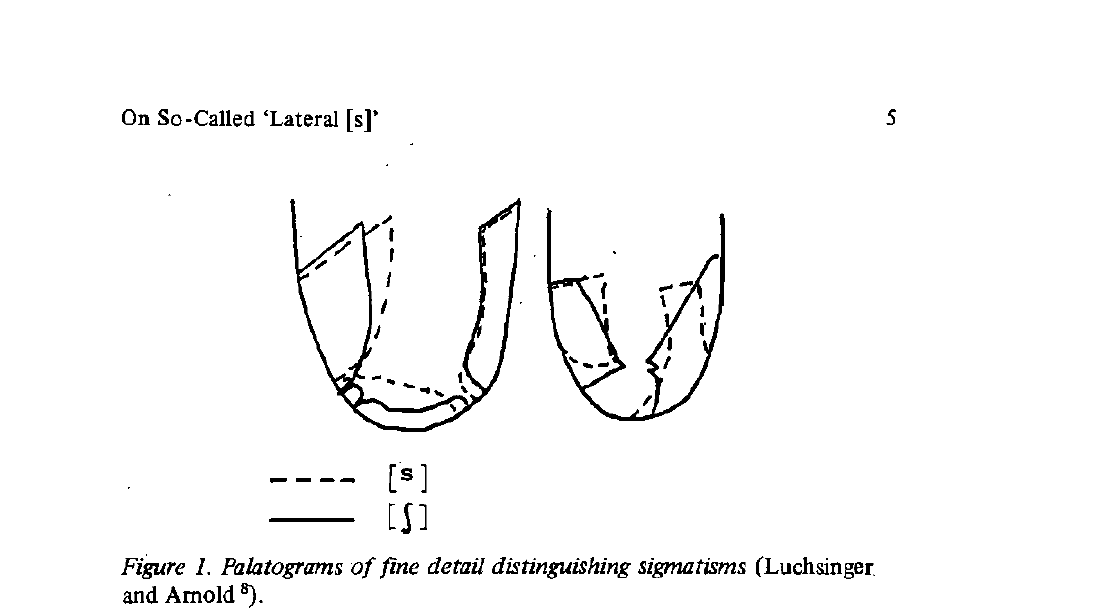
Figure 1. Palatograms of fine detail distinguishing sigmatisms (Luchsinger and Arnold